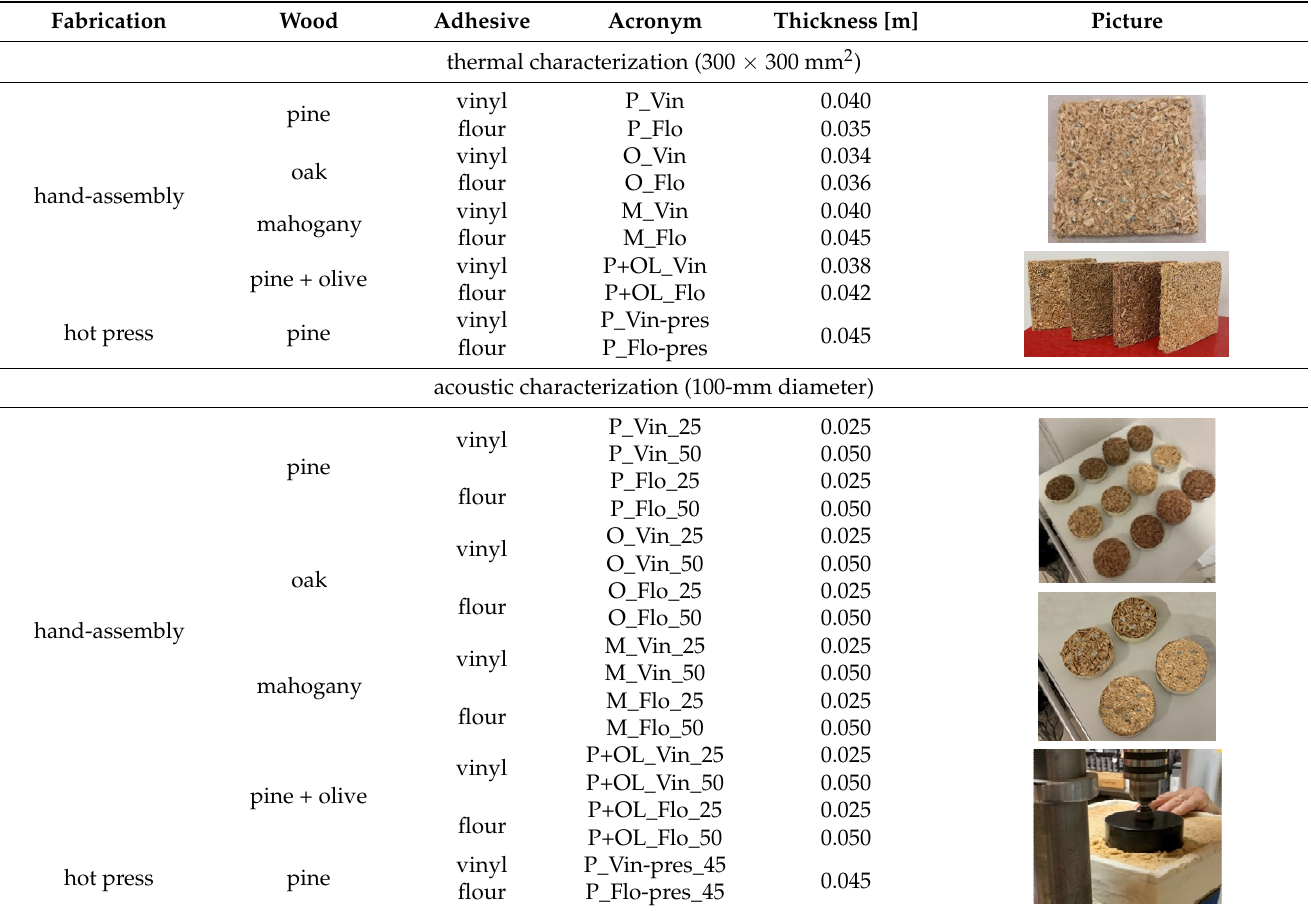
Table 1. Main features of the samples for thermal and acoustic